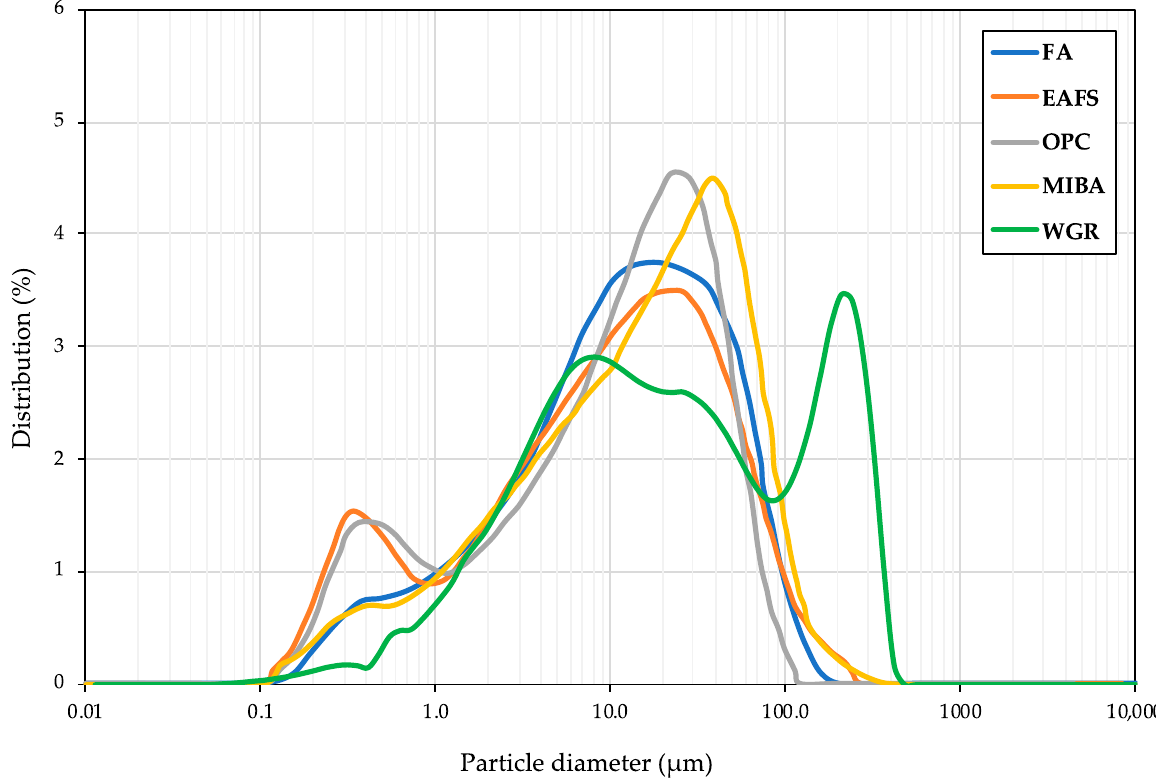
Figure 3. Particle size distribution for all precursors.